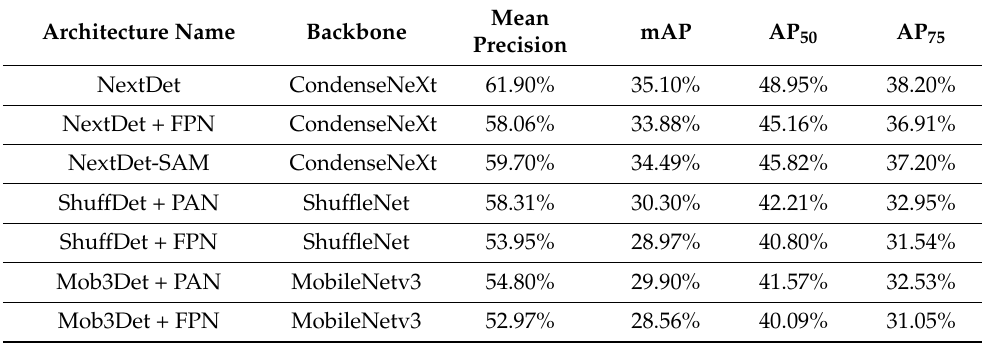
Table 2. A summary of performance comparison benchmarked on the Argoverse dataset.